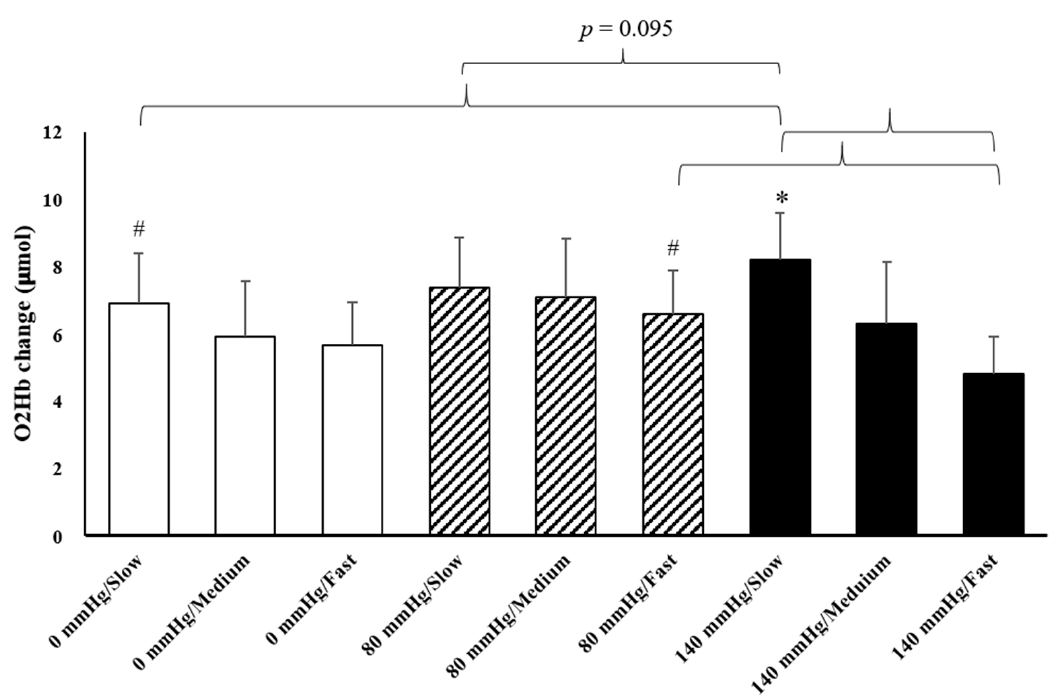
Figure 3. Changes in O2Hb to various pressure and rowing cadence conditions during the recovery period (mean ± SE). * Significantly different from a high cadence under 140 mmHg. # Significantly different from 140 mmHg at the same cadence.